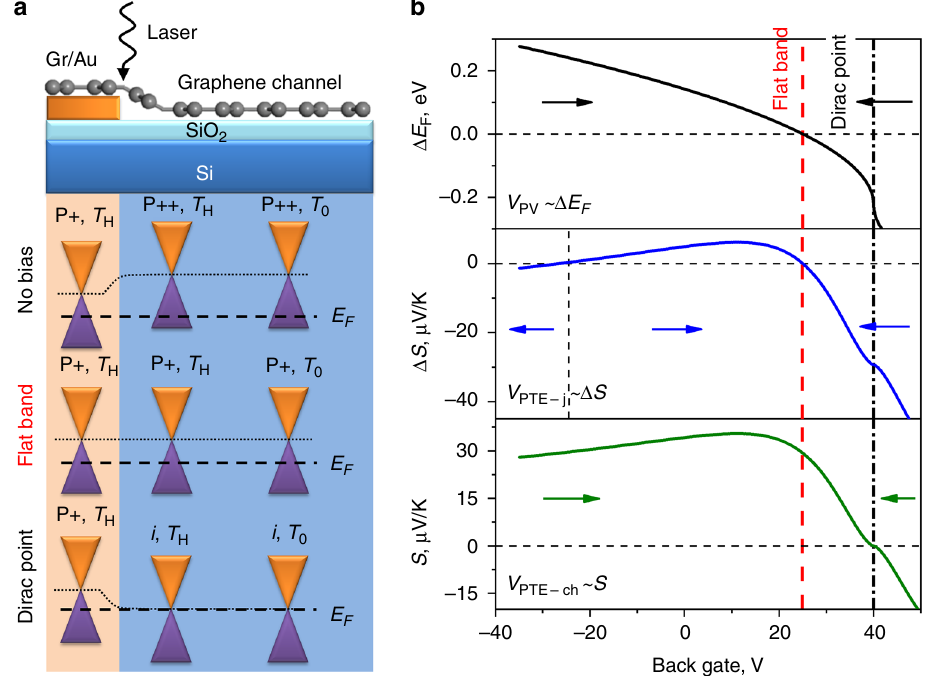
Fig. 1 Photocurrent generation mechanisms at graphene/metal interface. a Schematic of a graphene/Au interface and associated band diagrams for various gating conditions. The black dash line represents the Fermi level and the black dotted line represents the Dirac point of the graphene. The illumination is localized at the graphene/Au interface resulting in a higher local carrier temperature ( T H ) compared to the bath temperature ( T 0 ). b Calculated gate voltage dependence of Fermi level difference (top) and Seebeck coef fi cient difference (middle) between the Gr/Au and Gr/SiO 2 areas and gate voltage dependence of Seebeck coef fi cient for the graphene channel (bottom). The contributing current directions are indicated by arrows. Vertical red (dash) and black (dash – dot) lines correspond to the fl at band and Dirac points, respectively. Seebeck coef fi cients are calculated based on the conductivity model at T = 300 K. See Supplementary Discussion 1 for the calculation